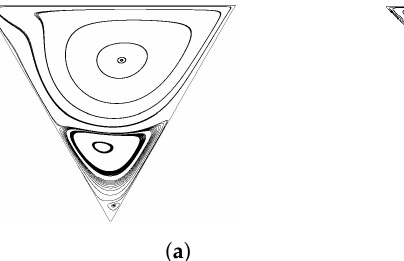
Figure 2. ( a ) Streamlines in the equilateral triangular cavity at Re = 500. ( b ) Streamlines in the right-angled isosceles triangular cavity at Re = 100.